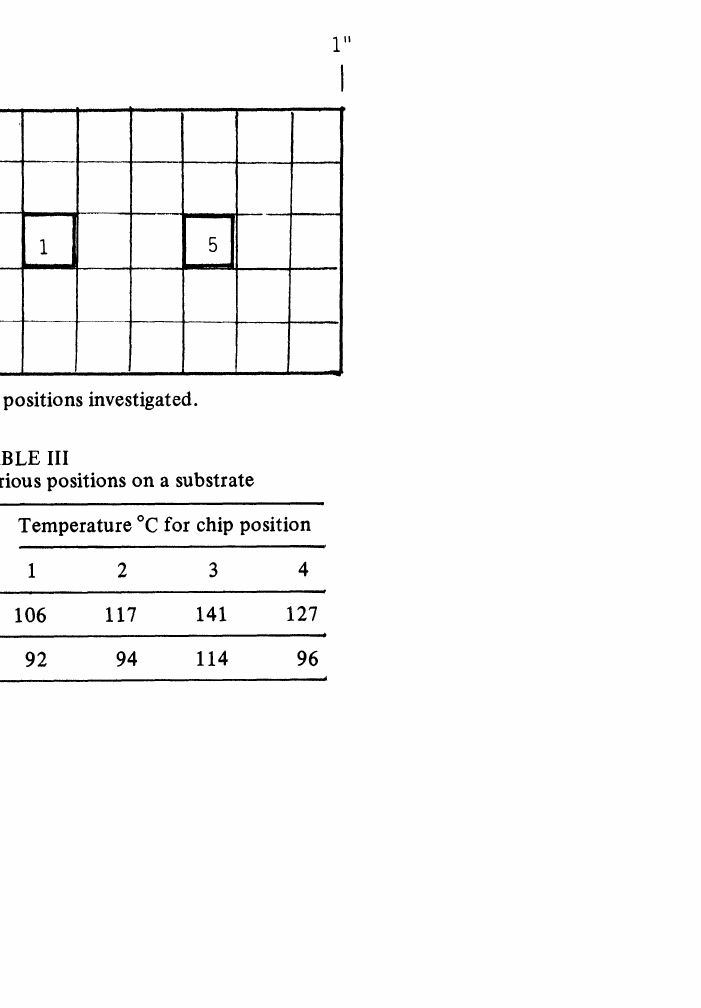
FIGURE 3 Chip positions investigated. TABLE III Chip temperature for various positions on a